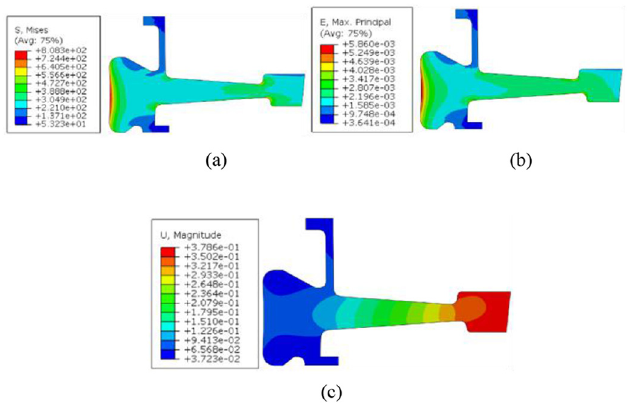
Fig. 7. Simulation results of FGM turbine disc in cruising state: (a) von Mises stress distribution nephogram, (b) strain distribu- tion nephogram, and (c) deformation distribution nephogram.